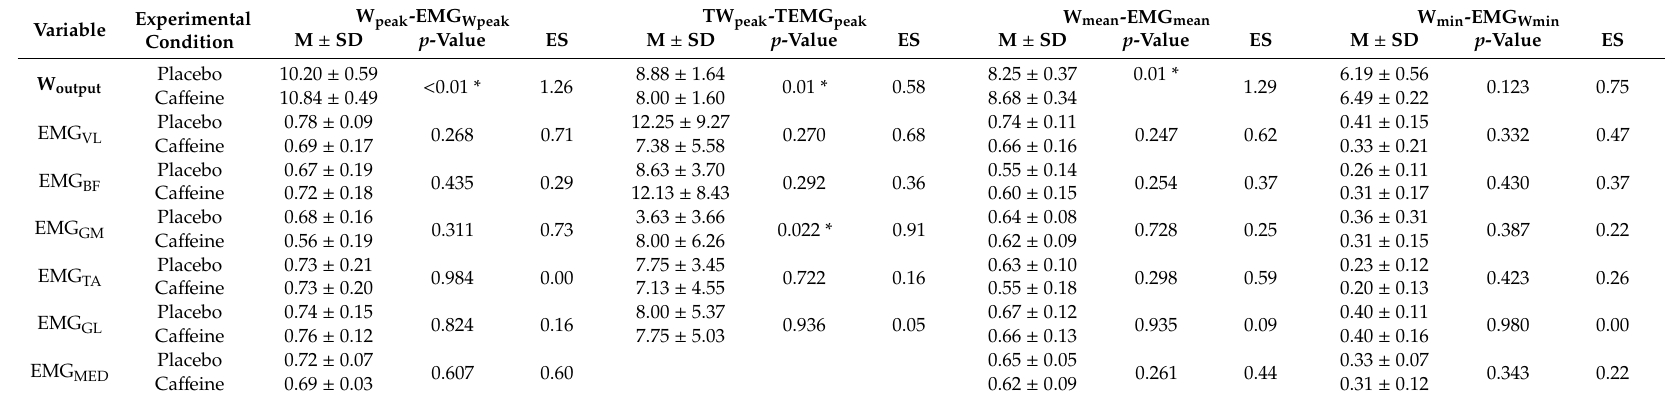
Table 1. Data for power output and root mean square-EMG (rms-EMG) recorded during the Wingate